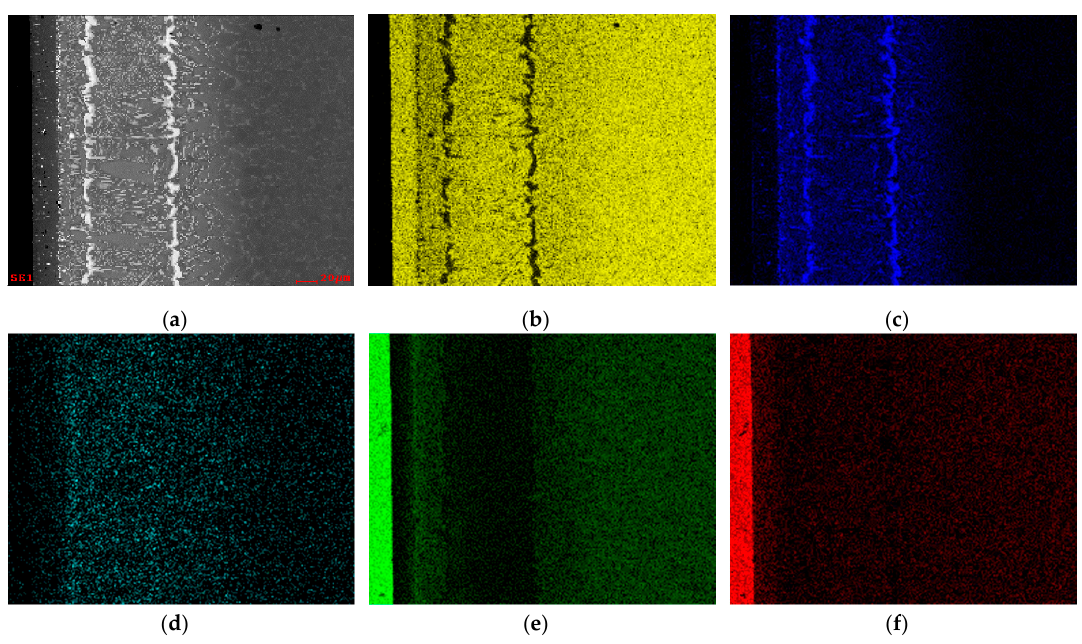
Figure 5. ( a ) SEM image and ( b ) Ti, ( c ) Ag, ( d ) Cu, ( e ) Al and ( f ) O EDS elemental maps of the brazed interface of Al 2 O 3 /Ti6Al4V joints produced at 980 °C for 30 min.